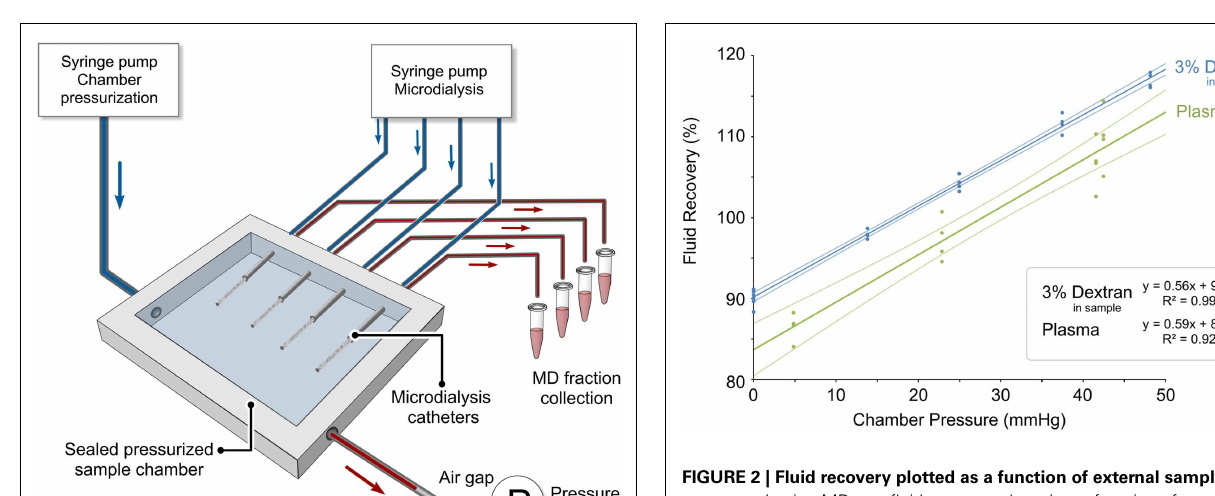
FIGURE 2 | Fluid recovery plotted as a function of external sample pressure . In vitro MD test fluid recovery plotted as a function of external sample pressure in dextran sample (blue) and plasma sample (green) (42). Reprinted with permission from Chu (42). Copyright 2014 Springer Science